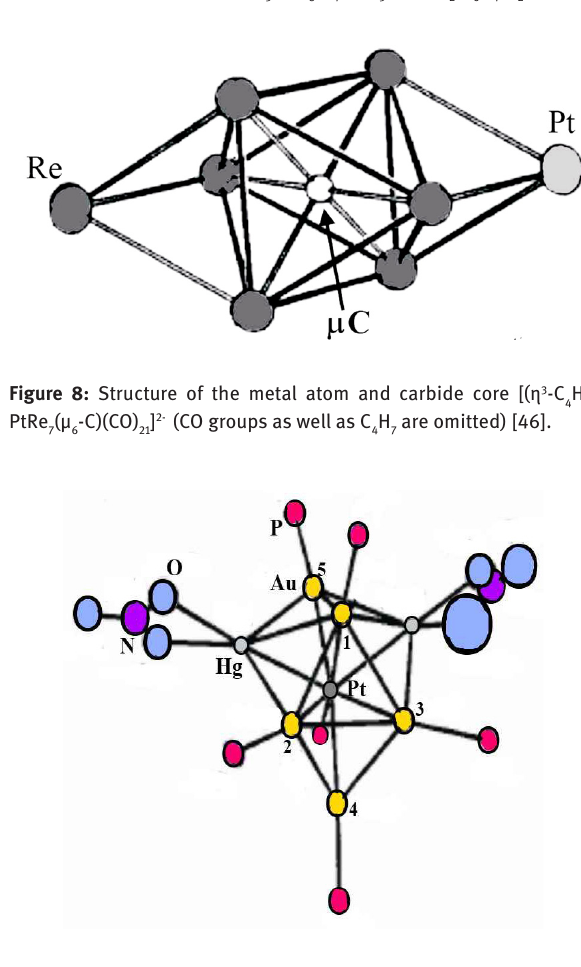
Figure 7: Structure of [(H)PtOs